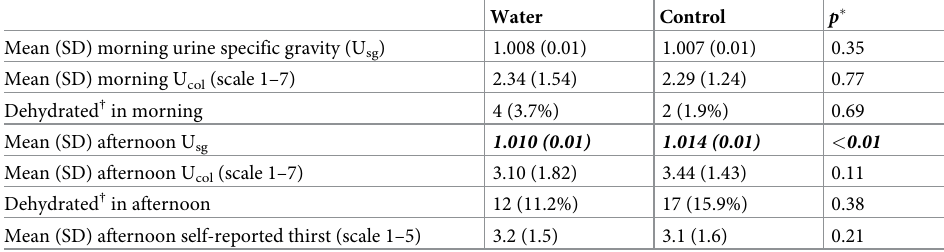
Table 1. Univariable associations between hydration indicators and study conditon (n = 107).